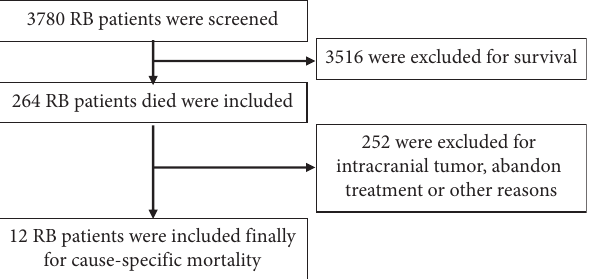
Figure 1: Eligibility evaluation flow diagram for 12 RB cause-specific mortality patients. A total of 3780 RB patients were initially screened. After excluding 3516 survivors, 264 RB patients who died were included. After excluding 252 patients for intracranial tumor, abandonment of treatment, or other reasons, 12 RB cause-specific mortality patients were finally included. Table 1: Characteristics of 12 RB cause-specific mortality patients.